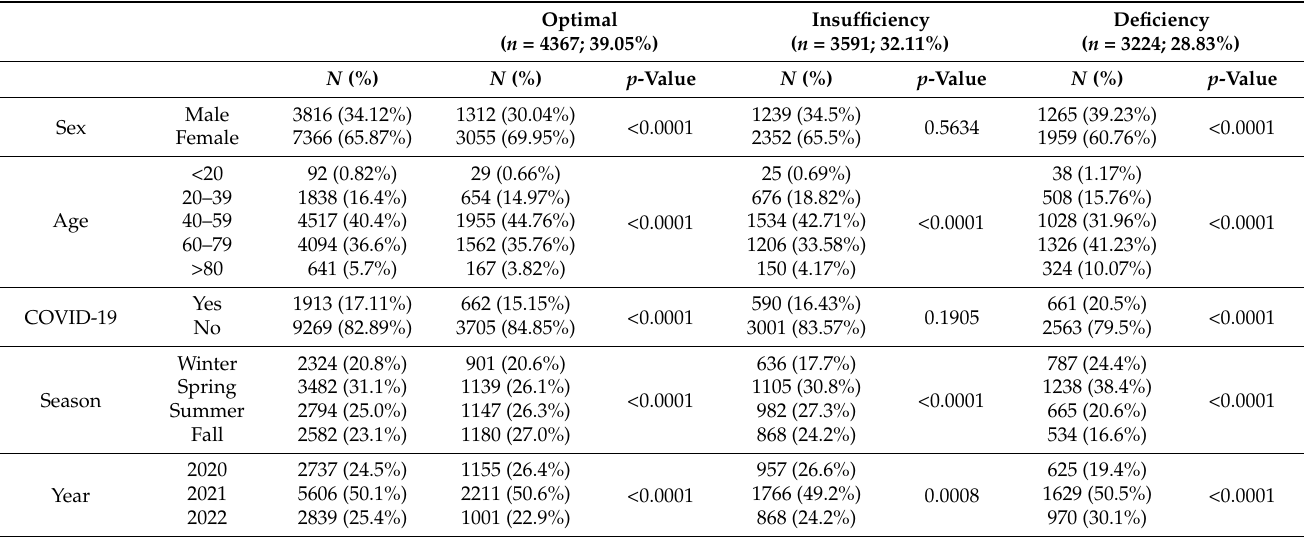
Table 2. Prevalence of deficiency and sufficiency by sex, age, season, years.